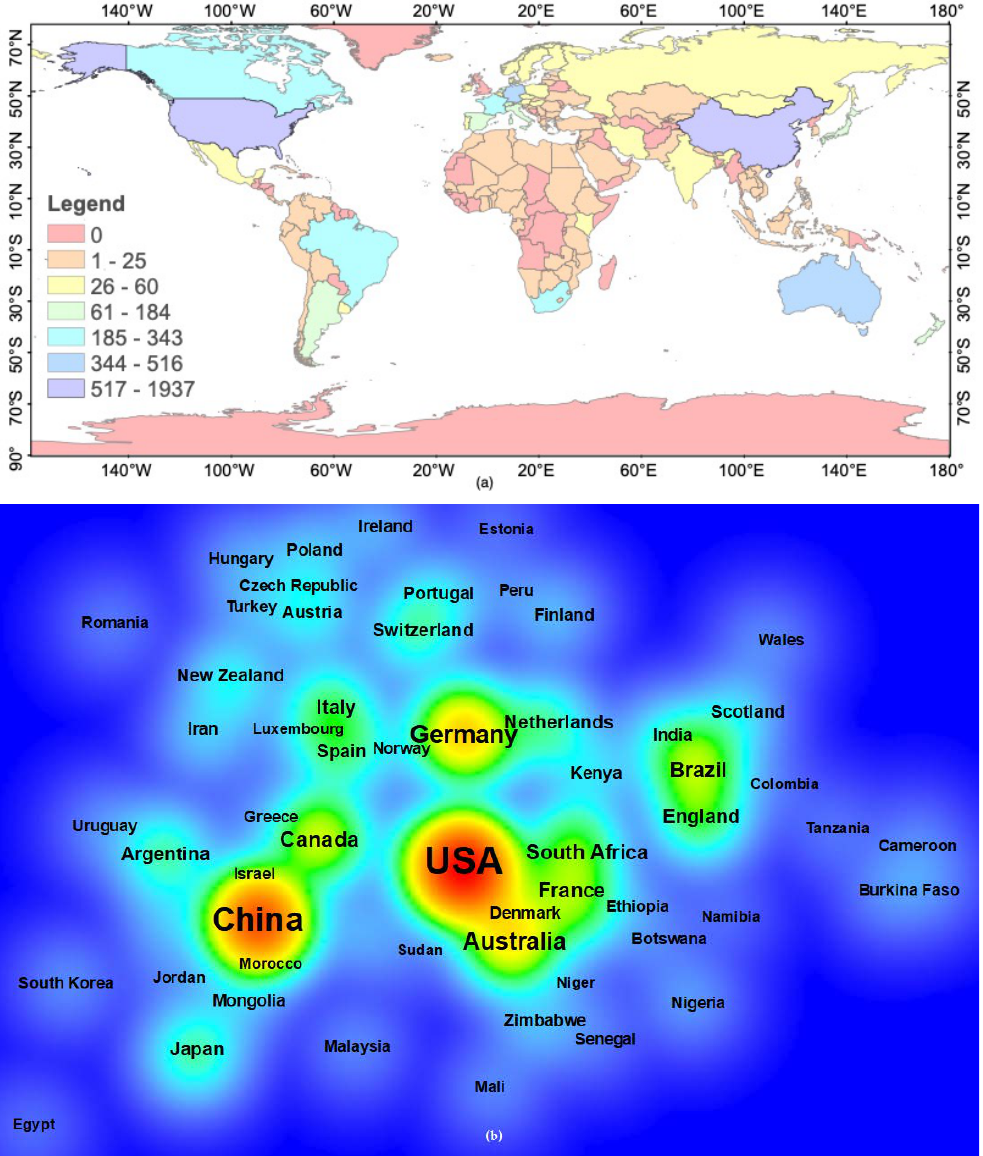
Figure 3. The number of documents per country ( a ) and cooperation density visualization between countries ( b ) in GRS research field.